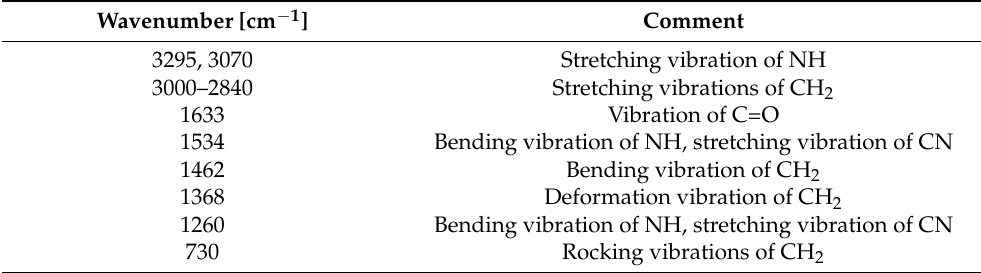
Table 3. FTIR ATR characteristic bands of polyamide and their assignment